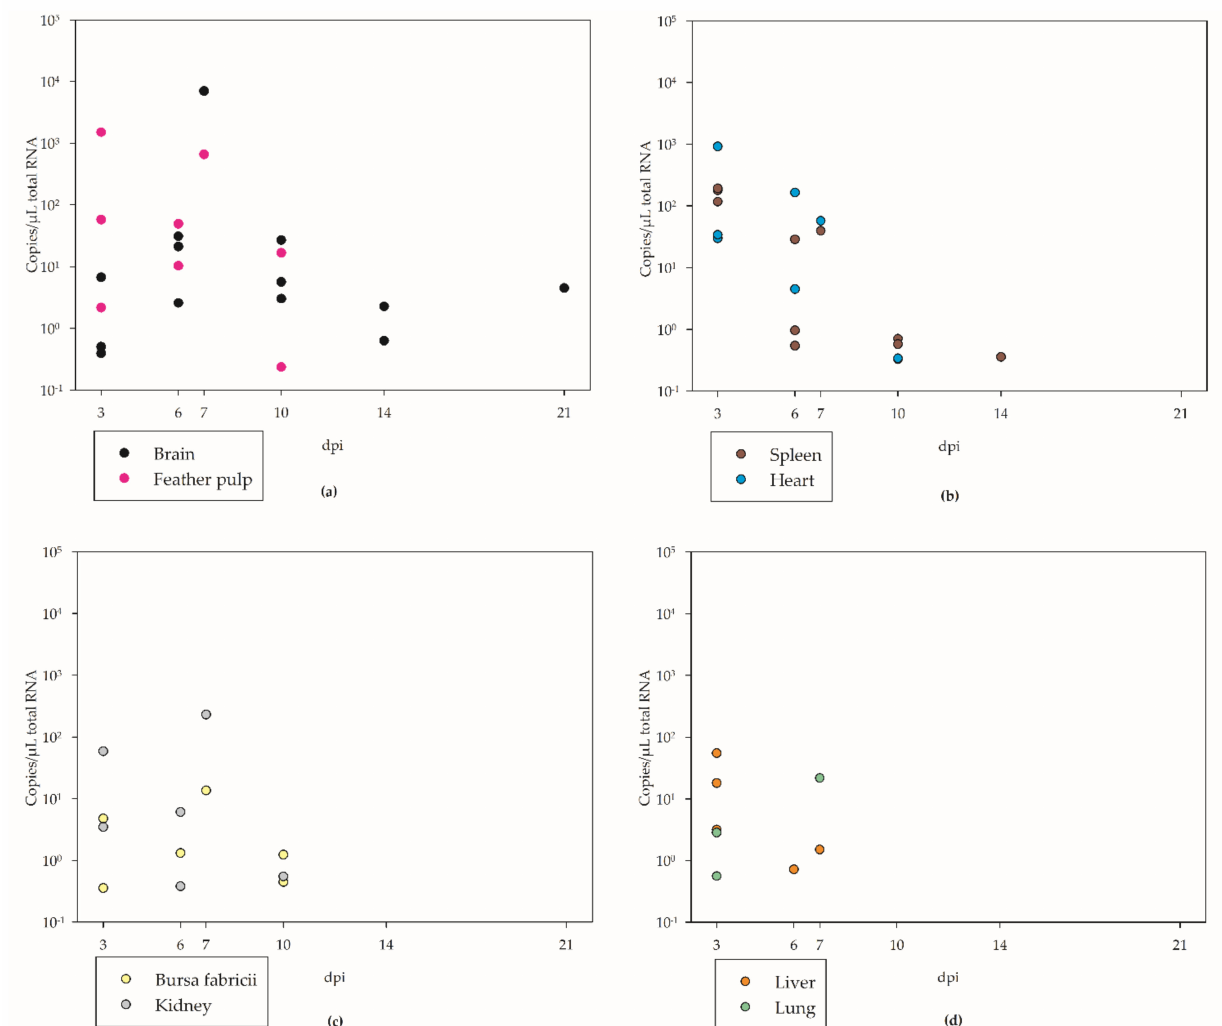
Figure 6. WN viral load in different organs of all WNV-inoculated geese as estimated by RT-qPCR (negative values are not shown) in: ( a ) brain and feather pulp; ( b ) spleen and heart; ( c ) bursa fabricii and kidney; and ( d ) liver and lung